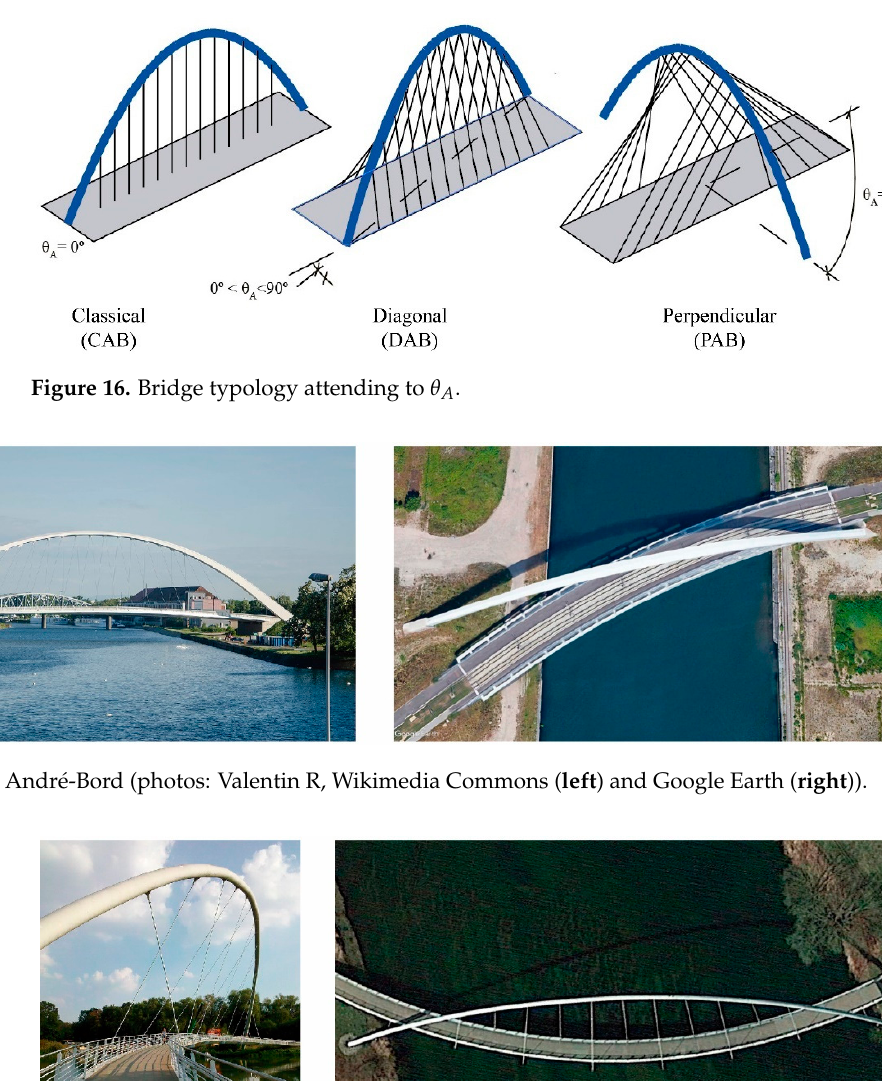
Figure 18. Tiergartenbrücke (photos: Cmuelle8, Wikimedia Commons ( left ) and Google Earth ( right )).